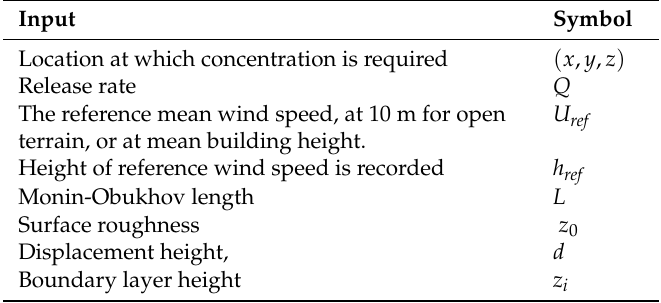
Table A1. Summary of input parameters required by reference model.